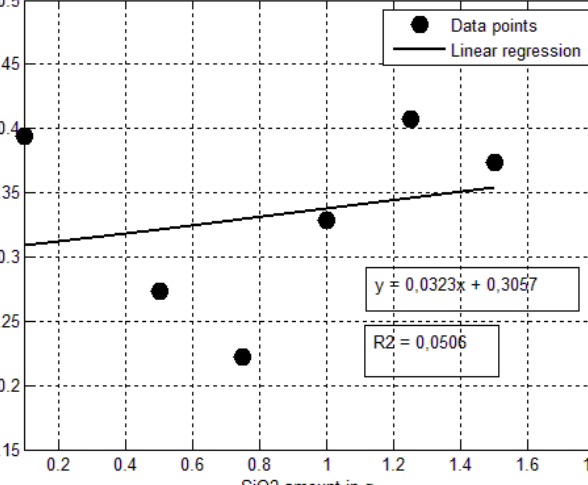
Figure 9. Regression model of the dependence of the strength index of the BIN “ chitosan-silicon dioxide ” composite on the amount of silicon dioxide in its texture .